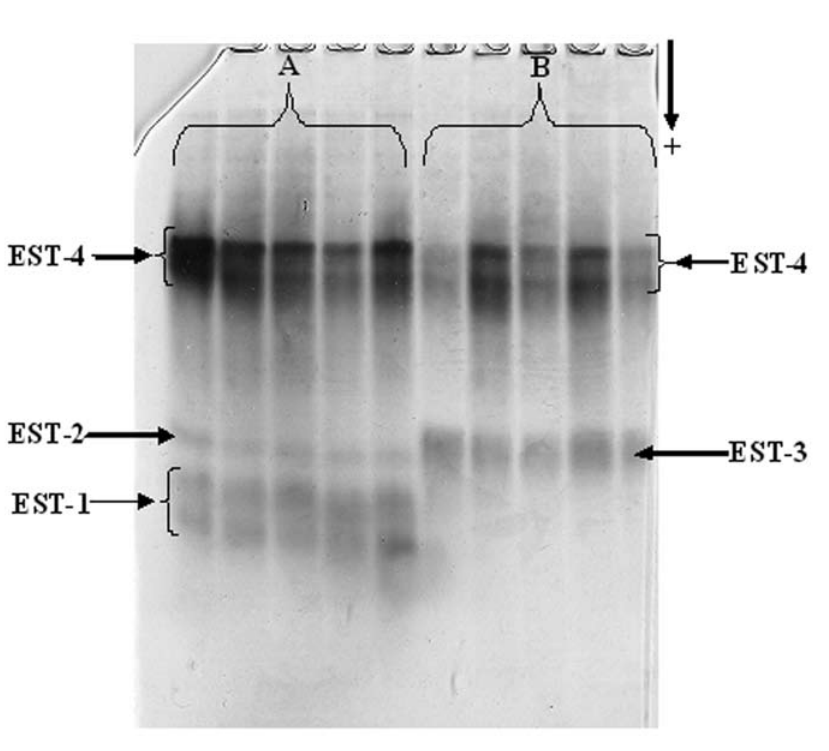
Fig. 1. Esterase isoenzymes profile in the PAGE system from head/thorax extracts of the Tetragonisca fiebrigi (A) and Tetragonisca angustula